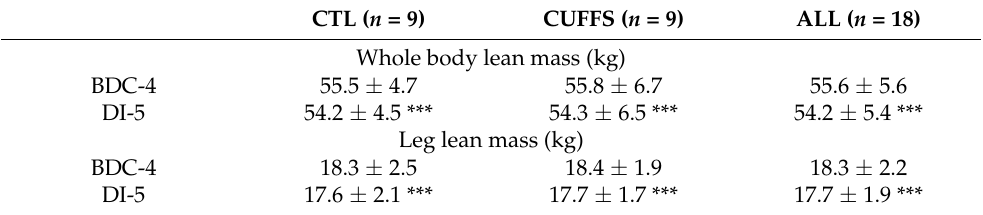
Table 2. Impact of 5 days of dry immersion on whole body and leg (right and left) lean